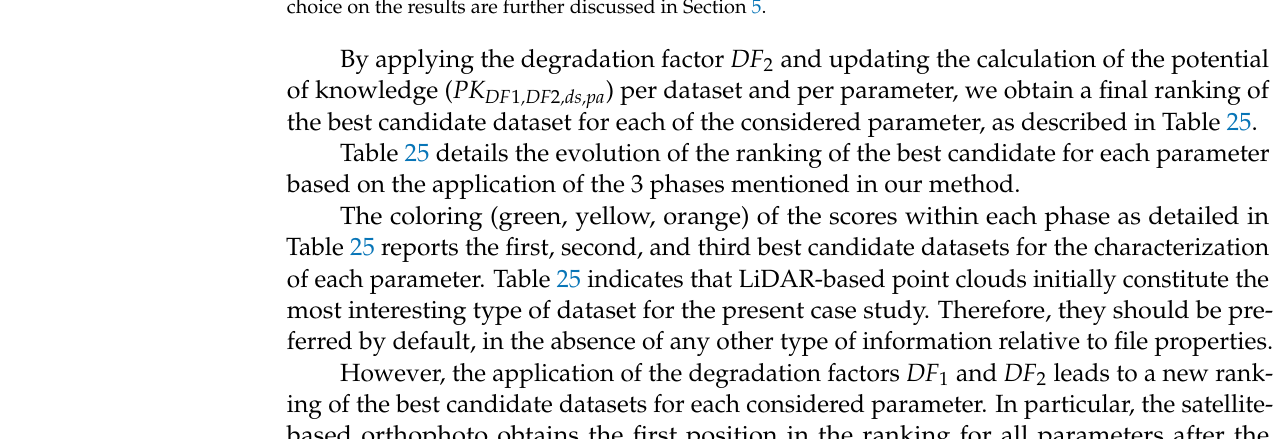
Table 25 details the evolution of the ranking of the best candidate for each parameter based on the application of the 3 phases mentioned in our